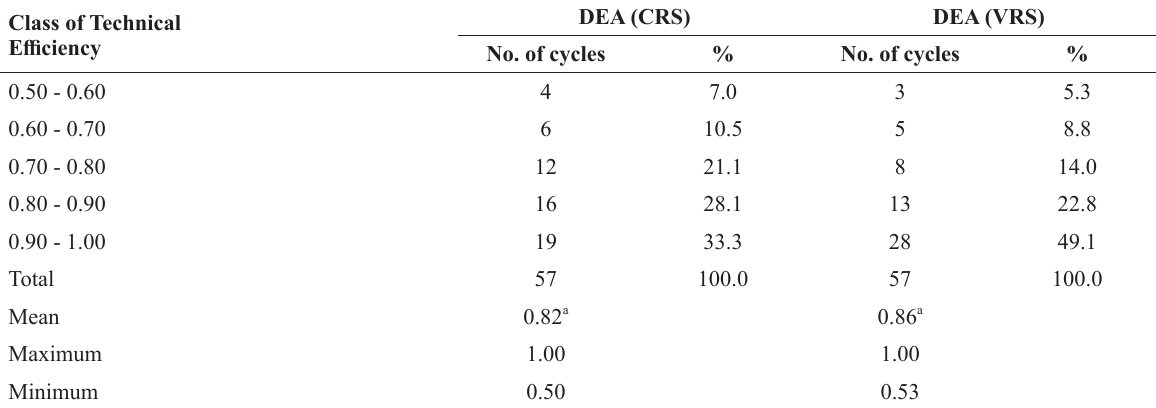
Different superscript letters in the same row indicate significant differences (p < 0.05).